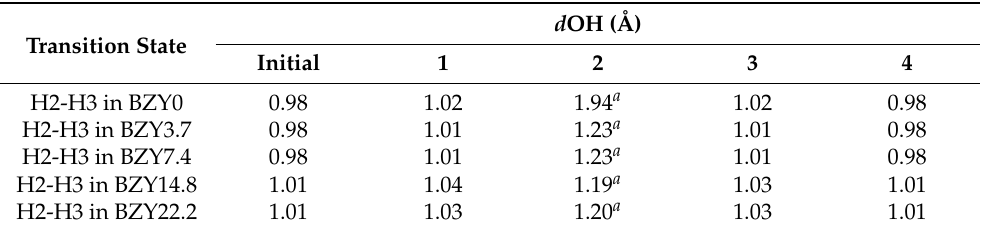
Table 2. Distance between Hydrogen and the Nearest Oxygen Atom ( d OH) at Transition States of Proton Transfer Step H2-H3 in Figure 8. Energy curves of ( a ) proton and ( b ) oxygen ion migration in BZYs.